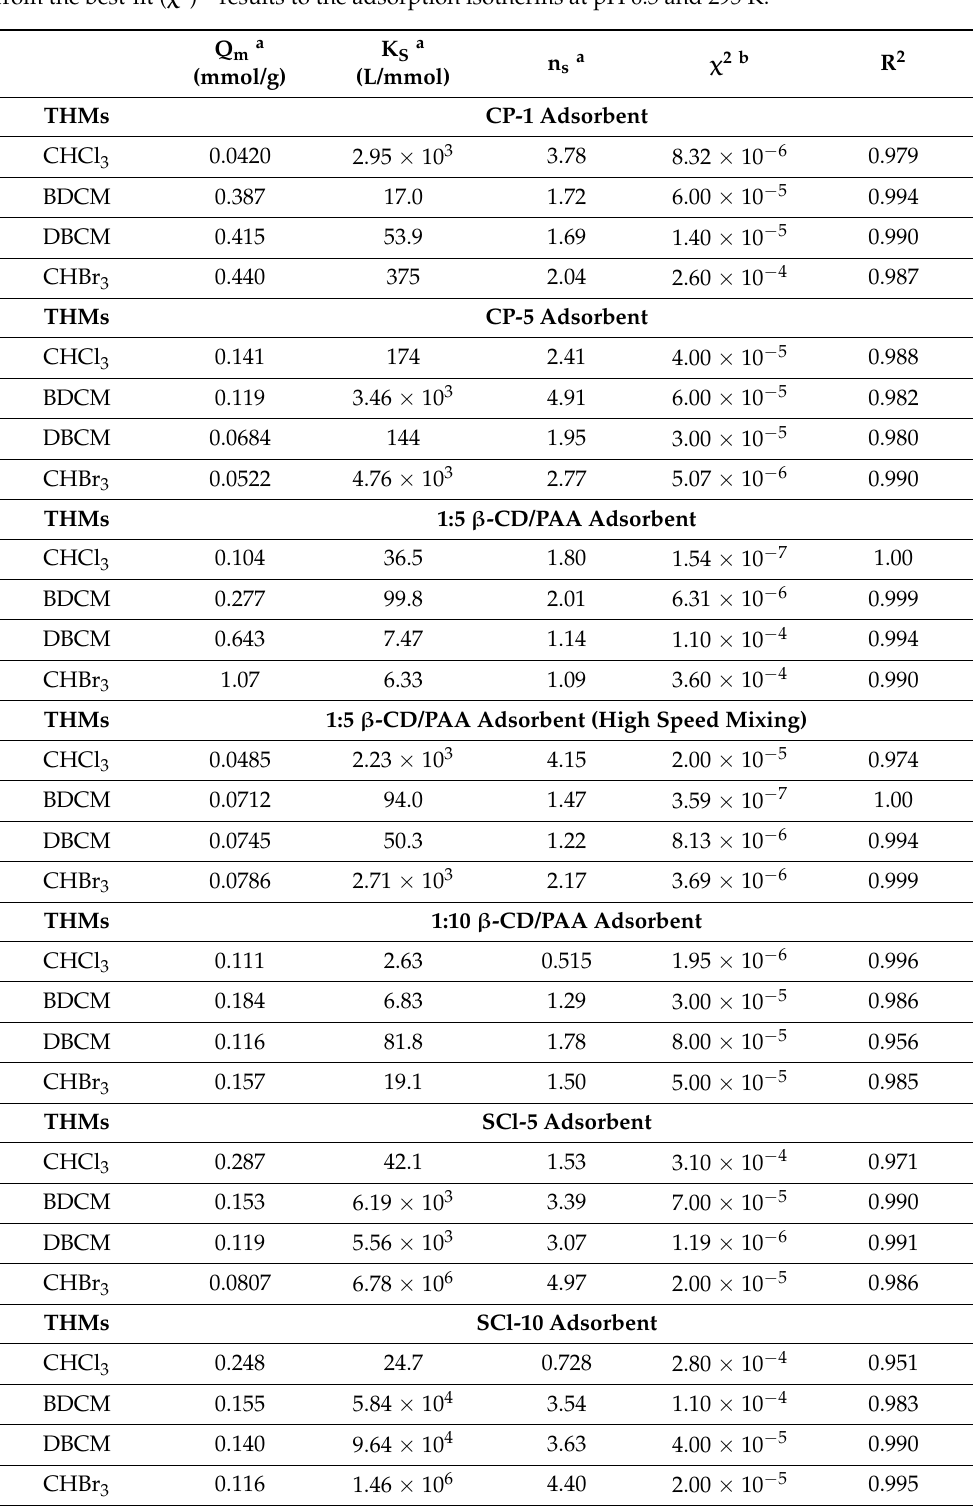
Table 4. Sips model parameters (Q m , K s and n s ) a for the copolymer materials * with THMs obtained from the best-fit ( χ 2 ) b results to the adsorption isotherms at pH 6.5 and 295